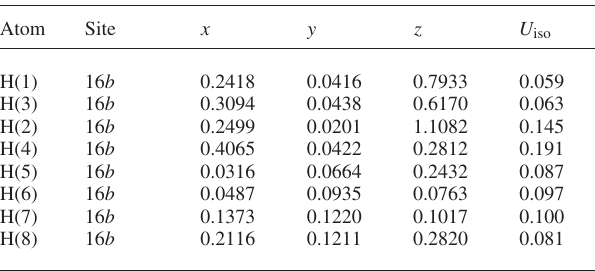
Table 2. Atomic coordinates and displacement parameters (in Å 2 )